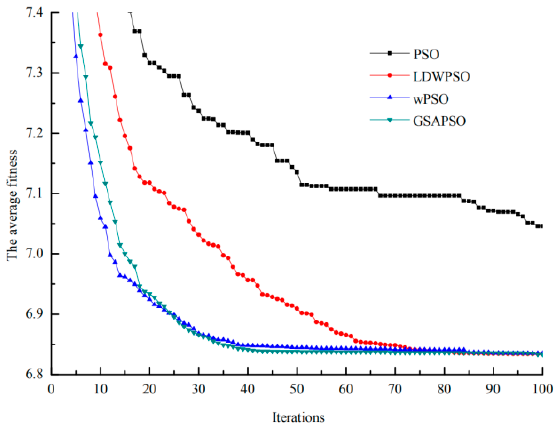
Figure 4. Convergence curves of average fitness using different algorithms.